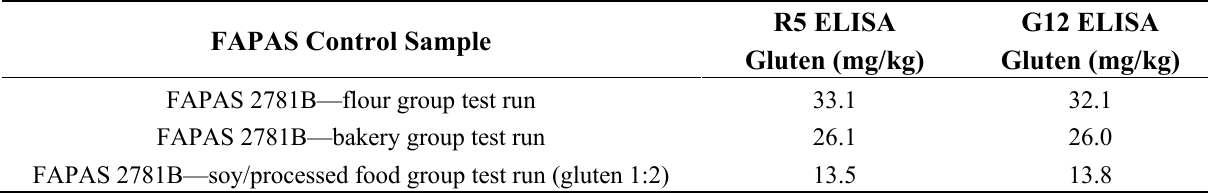
Table 2. Results of the food analysis performance assessment scheme (FAPAS) proficiency test material.